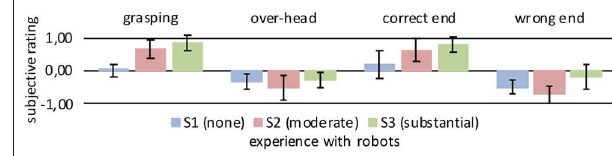
FIGURE 5 | Mean subjective ratings at key robot positions. Key robot positions are depicted in Figure 4 . Rating sample from cube with 40cm side length centered on key pose. The error bars show the standard deviation of the rating sample.